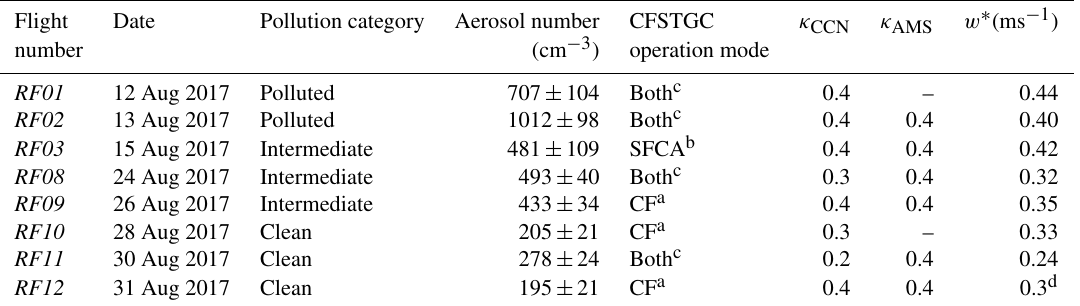
Table 1. Average marine-boundary-layer (MBL) aerosol concentrations from the UHSAS CCN activity derived from in situ CCN measure- ments ( κ CCN ), bulk chemical composition ( κ AMS ), and characteristic vertical updraft velocity ( w ∗ ). Aerosol conditions are classified for each flights as polluted, intermediate, or clean based on the MBL aerosol